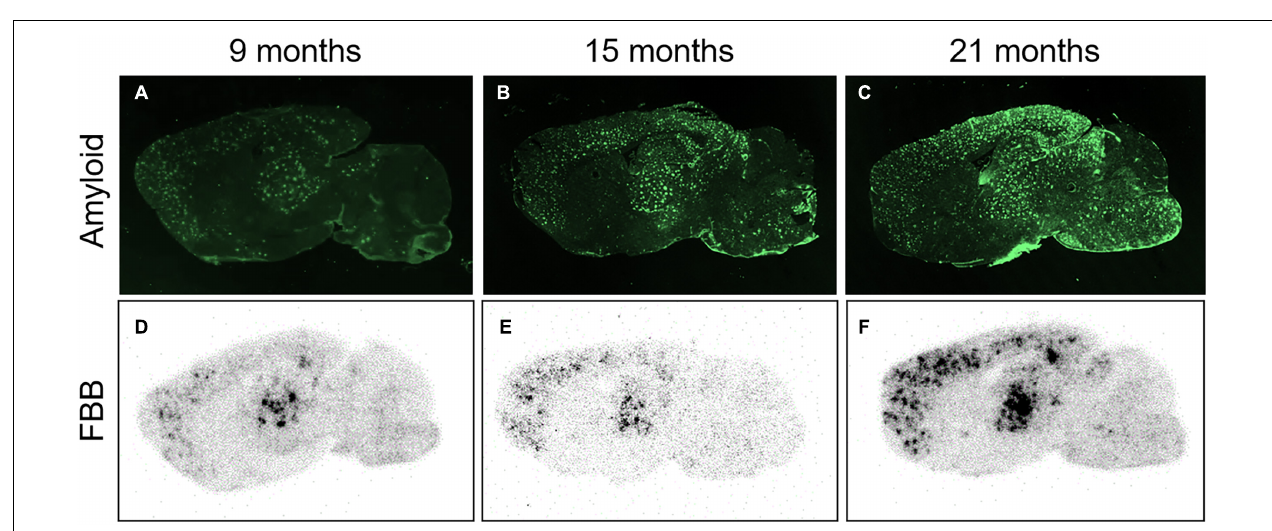
FIGURE 2 | Quantification of FBB retention measured by PET and ex vivo autoradiography. (A) In vivo tracer retention was quantified in cortical and hippocampal VOIs with cerebellum as reference region and expressed as cortex-to-cerebellum (cx/cb) and hippocampus-to-cerebellum ratios (hip/cb), respectively. Data are expressed as mean ± SEM; ns, not significant, ** p < 0.001, *** p < 0.0001 vs. wild-type (wt). (B) Volumetric quantification of cortex-to-cerebellum ratios (cx/cb) as measured by PET and autoradiography in the very same animal, respectively, are plotted against each other (linear regression line, R 2 = 0.9). Each symbol represents one ARTE10 mouse of the respective age groups (triangle) or a wild-type mouse (square).